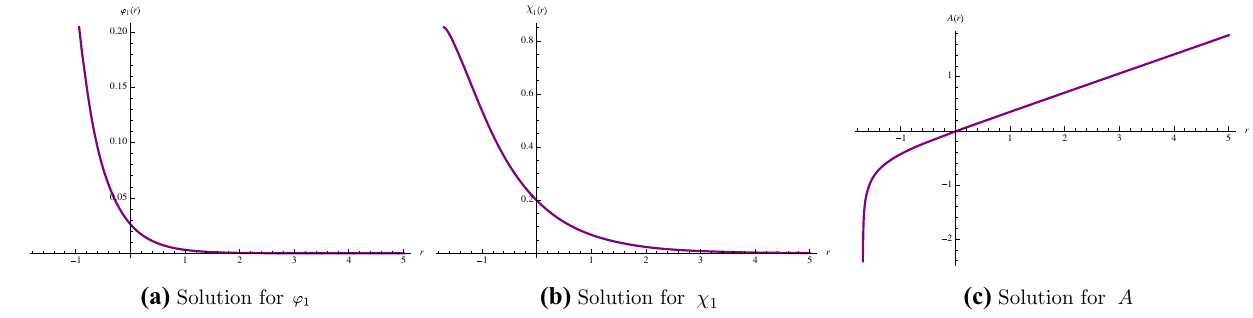
Fig. 1 An N = 1 RG flow with marginal and irrelevant deformations from type IIB